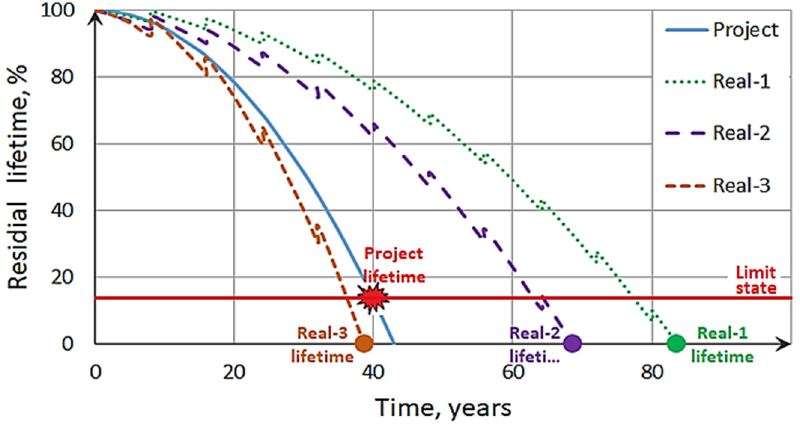
Figure 2. Comparison of the project and the actual individual lifetime. Project—lifetime assessment at the design stage, Real-1, Real-2, Real-3—lifetime assessment under various scenarios of actual operating conditions and performed repairs